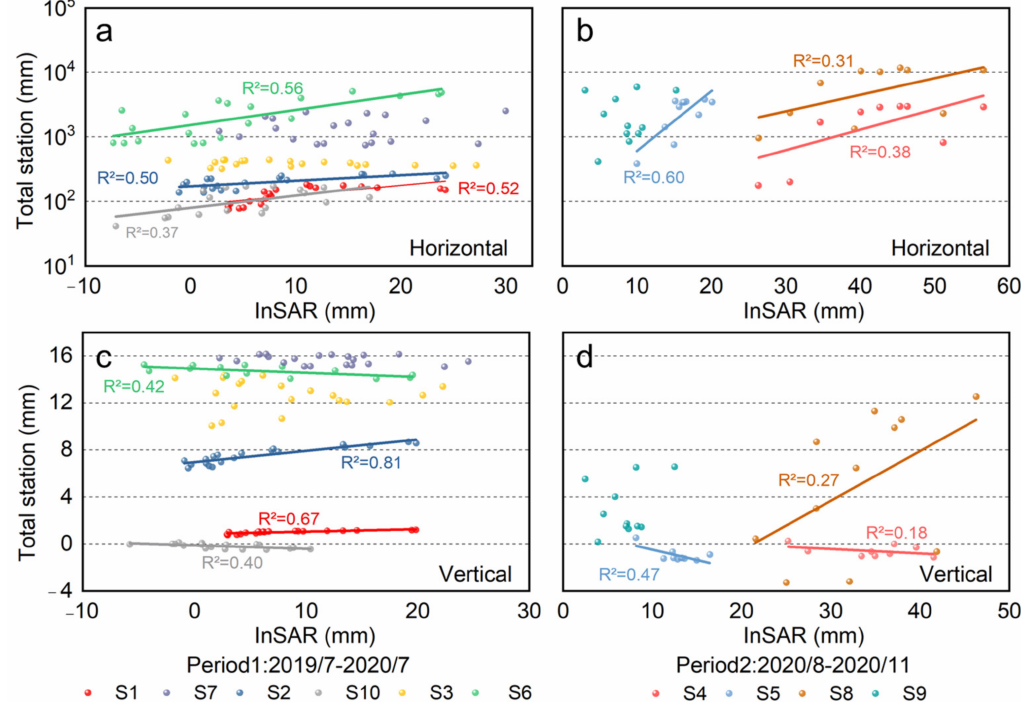
Figure 8. Comparison of InSAR interferometry and total station monitoring results. The comparison was conducted through two different monitoring periods. ( a , b ) Comparison of the horizontal deformation. ( c , d ) Comparison of the vertical deformation, whereby positive values represent uplift and westward deformation and negative values represent settlement and eastward deformation. The locations of the monitoring points are shown in Figure